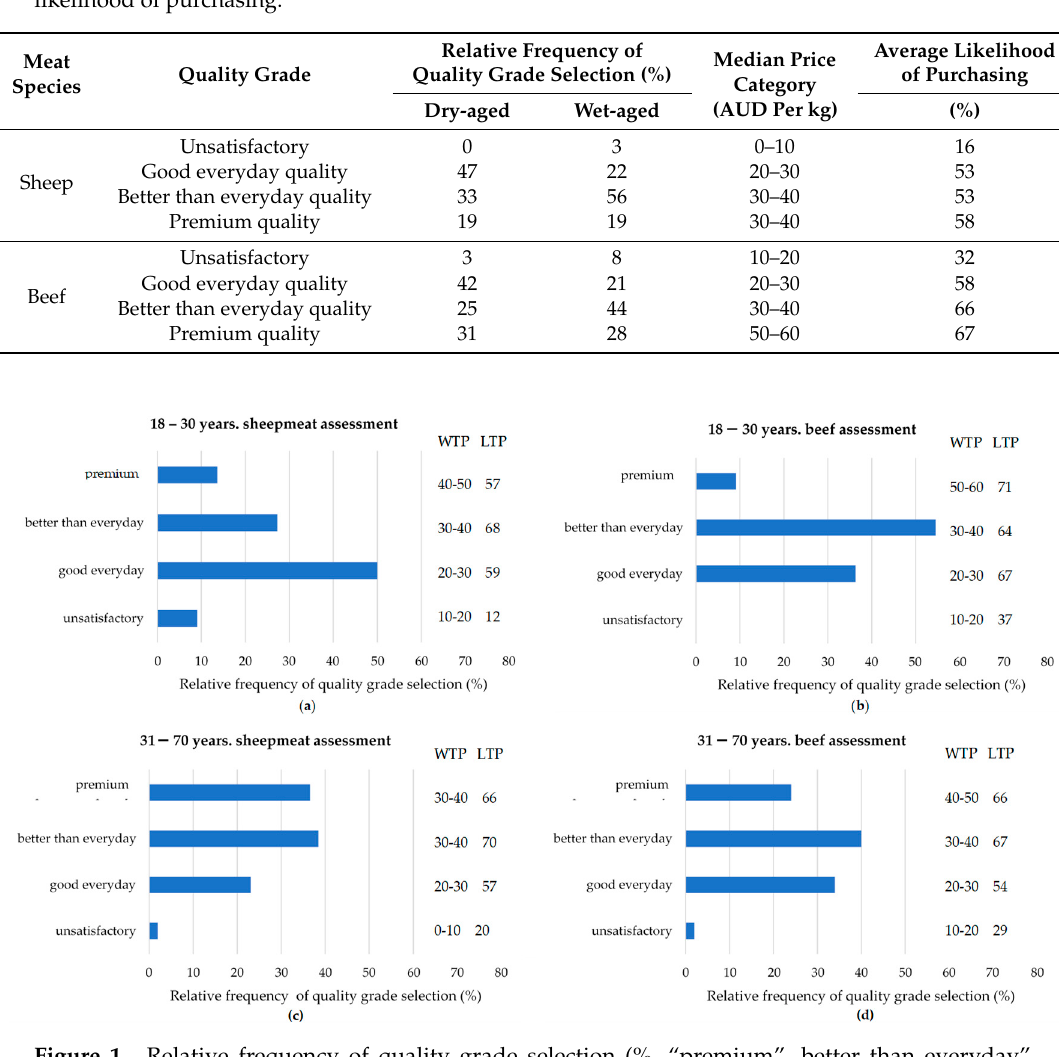
Figure 1. Relative frequency of quality grade selection (%, “premium”, better than everyday”, “good everyday”, “unsatisfactory”), willingness to pay (WTP; in AUD per kg.) and likelihood to purchase (LTP; %) for each quality grade split on age category and species. ( a ) 18–30 years, sheepmeat assessment; ( b ) 18–30 years, beef assessment; ( c ) 31–70 years, sheepmeat assessment; ( d ) 31–70 years, beef assessment.